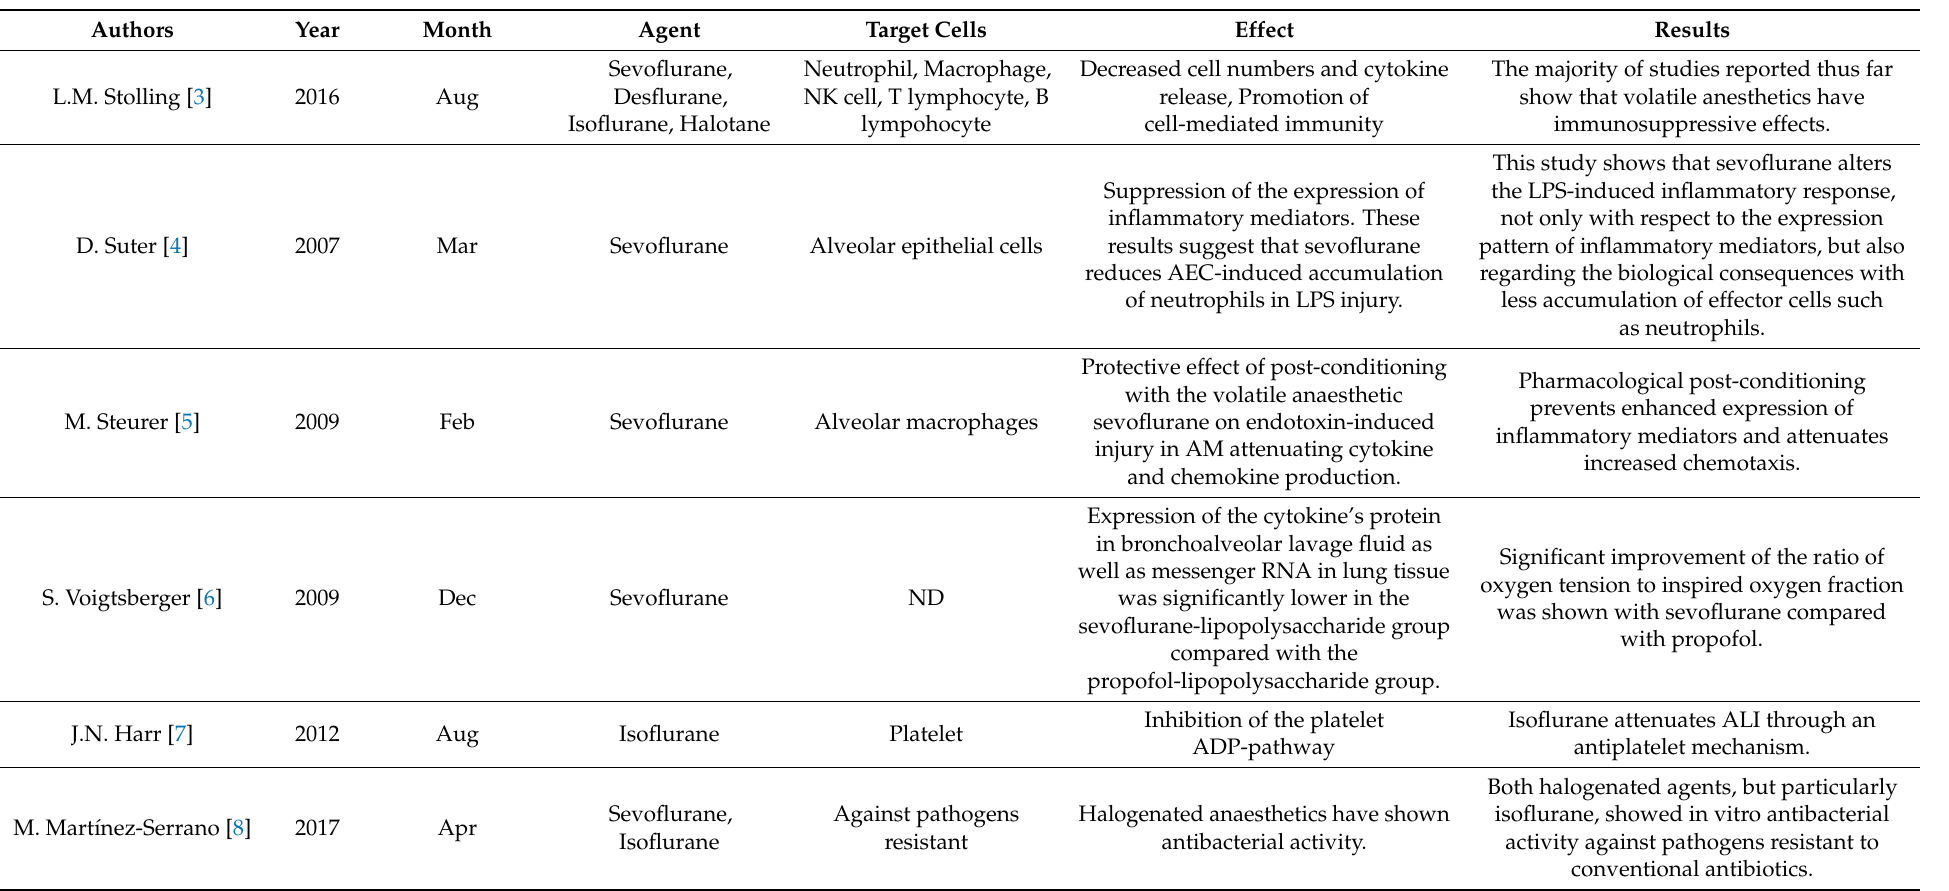
Table 3. Protective effects of halogenated